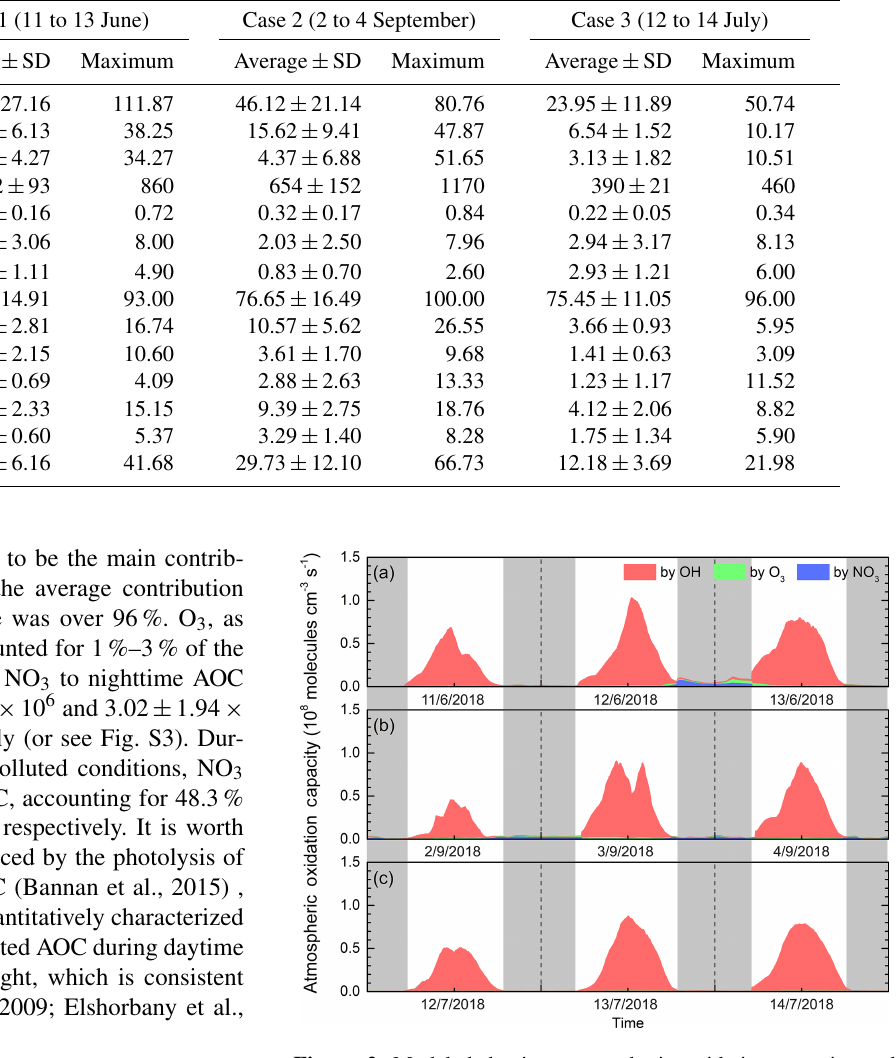
Figure 2. Modeled daytime atmospheric oxidation capacity and contributions of major oxidants at an urban site of Shanghai dur- ing (a) Case 1, (b) Case 2 and (c) Case 3. The gray areas denote the nighttime